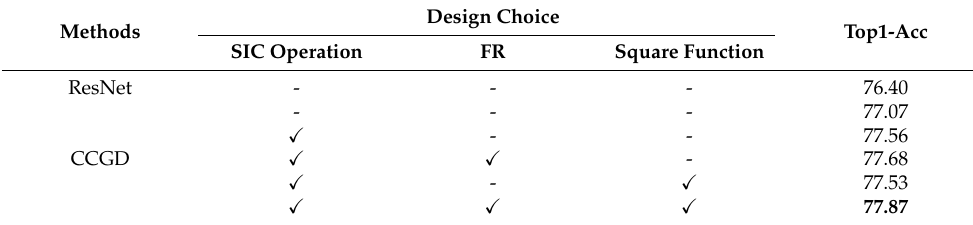
Table 4. Ablation experiments on ImageNet dataset. Result in bold is the best.